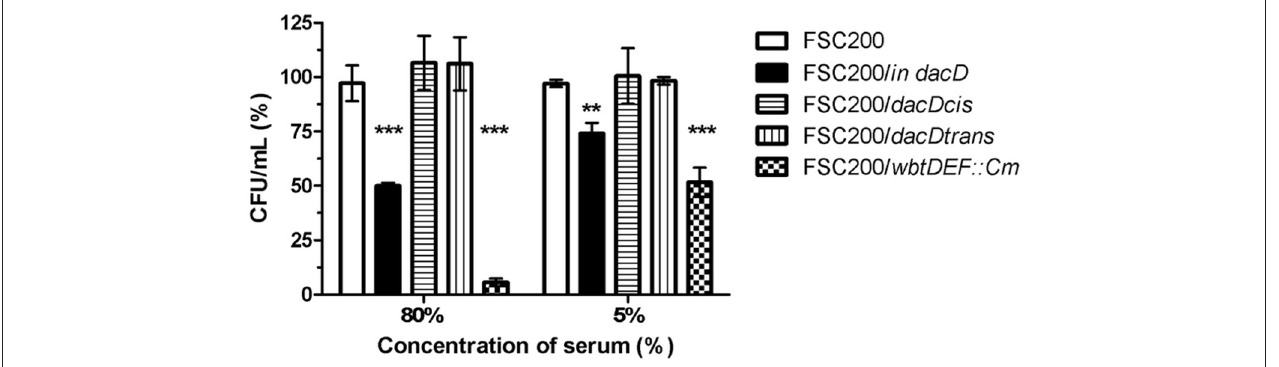
FIGURE 8 | Sensitivity to bactericidal effects of human serum. FSC200, FSC200/ in dacD , FSC200/ dacDtrans , FSC200/ dacDcis and FSC200/ wbtDEF::Cm strains were incubated with human nonimmune serum and their resistance/susceptibility was determined by CFU counts. FSC200/ wbtDEF::Cm strain is highly susceptible to the effects of complement and the strain was used as a positive control for serum complement activity. ** P < 0.01, *** P <